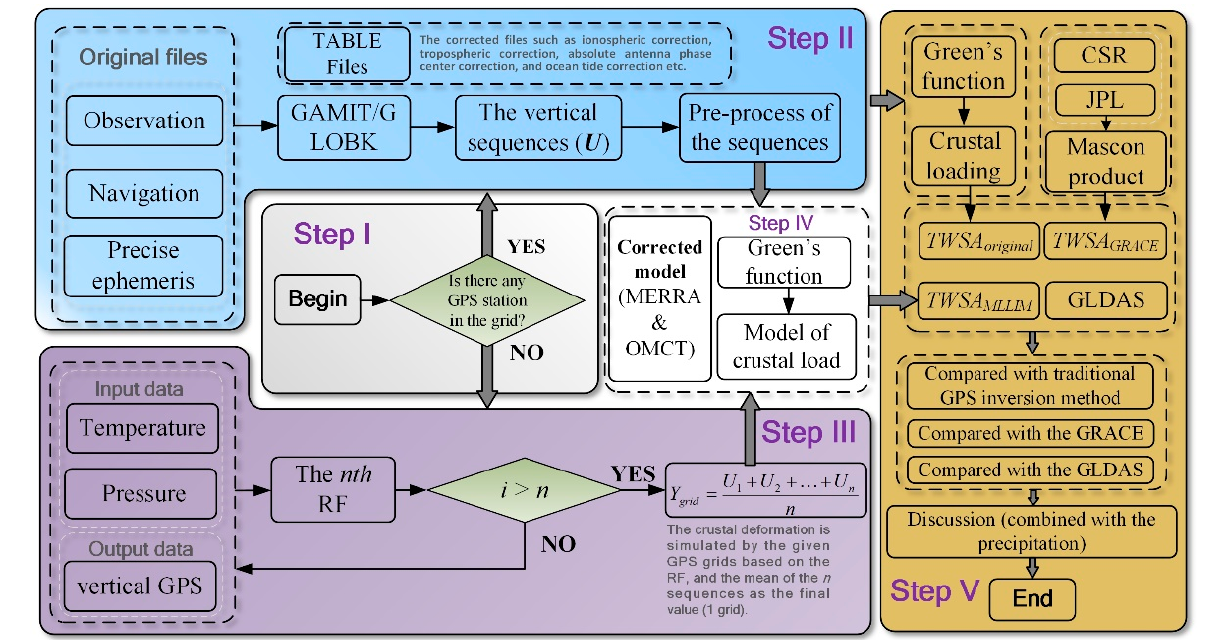
Figure 4. The flow chart of the MLLIM.